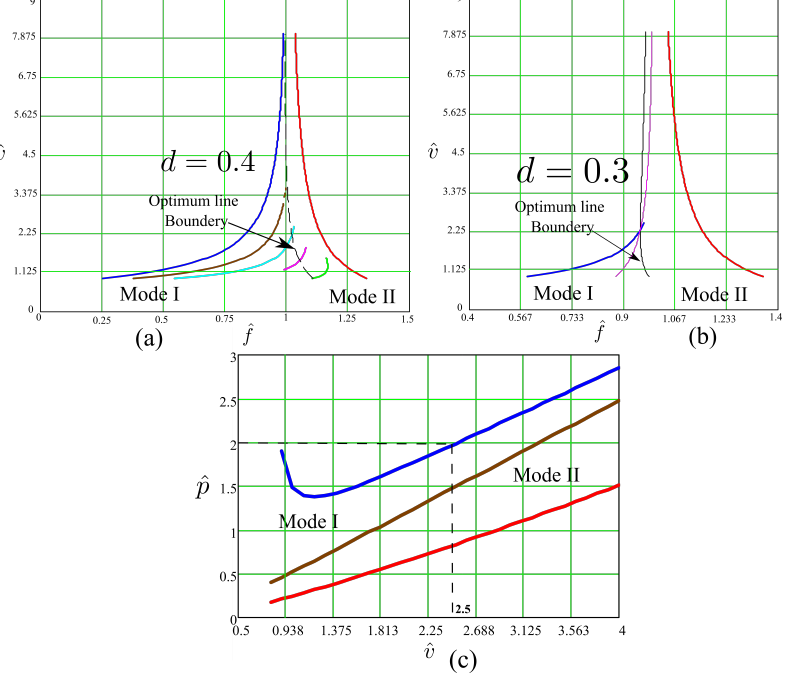
Figure 4. Graphical illustration of Equation (3); where ( a ) and ( b ) show the normalized output voltage vs normalized frequency for the duty d = 0.4 and d = 0.3 respectively. While ( c ) show the normalize power vs normalized output